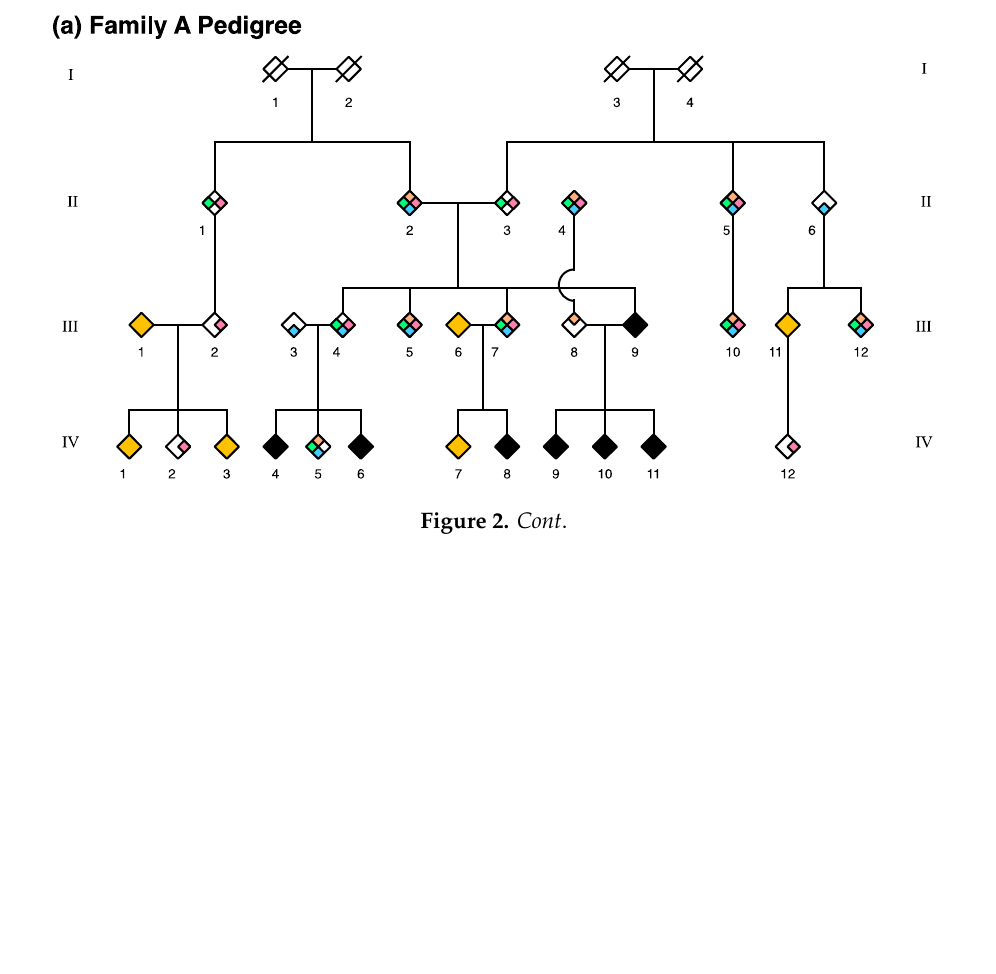
Figure 2. Scrambled pedigrees for Family A (panel a ) and Family B (panel b ) showing phenotypes and endophenotypes. All individuals with 1 endophenotype had the BAP, with the exception of two individuals from Family B (III ‐ 3 and IV ‐ 9) marked with an asterisk. These two individuals were clinically determined as unaffected but had above threshold endophenotype scores based on ROC curves. Some family members who were not phenotyped are not shown to preserve the anonymity of these families. The arrow indicates the proband shown in this pedigree. *: “All individuals with 1 endophenotype had the BAP, with the exception of two individuals from Family B (III ‐ 3 and IV ‐ 9) marked with an asterisk. These two individuals were clinically determined as unaffected but had above threshold endophenotype scores based on ROC curves.”. 2.4. Correlates of the BAP Endophenotypes Across both families, no sex or age differences were observed for any of the endophenotypes (all p > 0.200). Overall, a more severe BAP presentation (indicated by a greater number of endophenotypes) was associated with reduced social adaptive functioning on both self ‐ report and objective measures of social communication (Table 3), demonstrating good convergent validity. In particular, a more severe BAP presentation showed a strong correlation with more severe pragmatic language difficulties, with scores for each endophenotype also significantly correlated. A similar